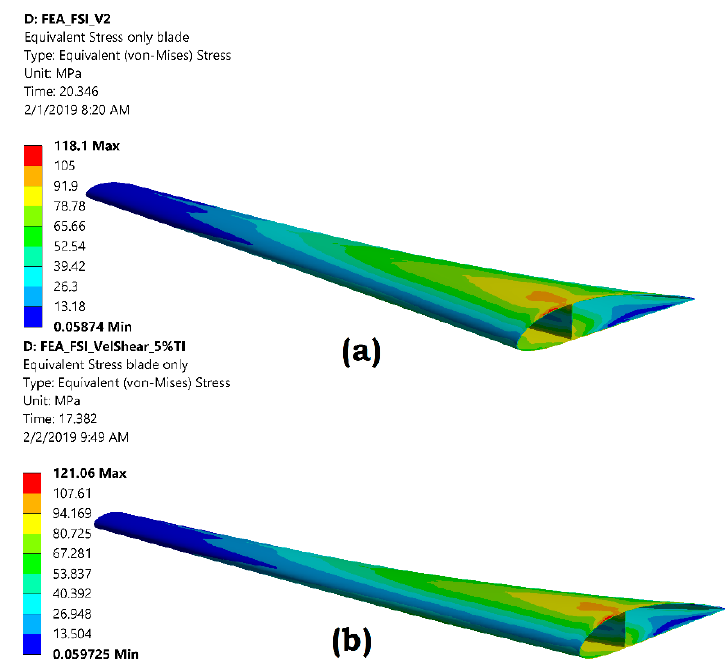
Figure 14. Contour plot of blade equivalent stress for ( a ) uniform velocity; ( b ) velocity profile.